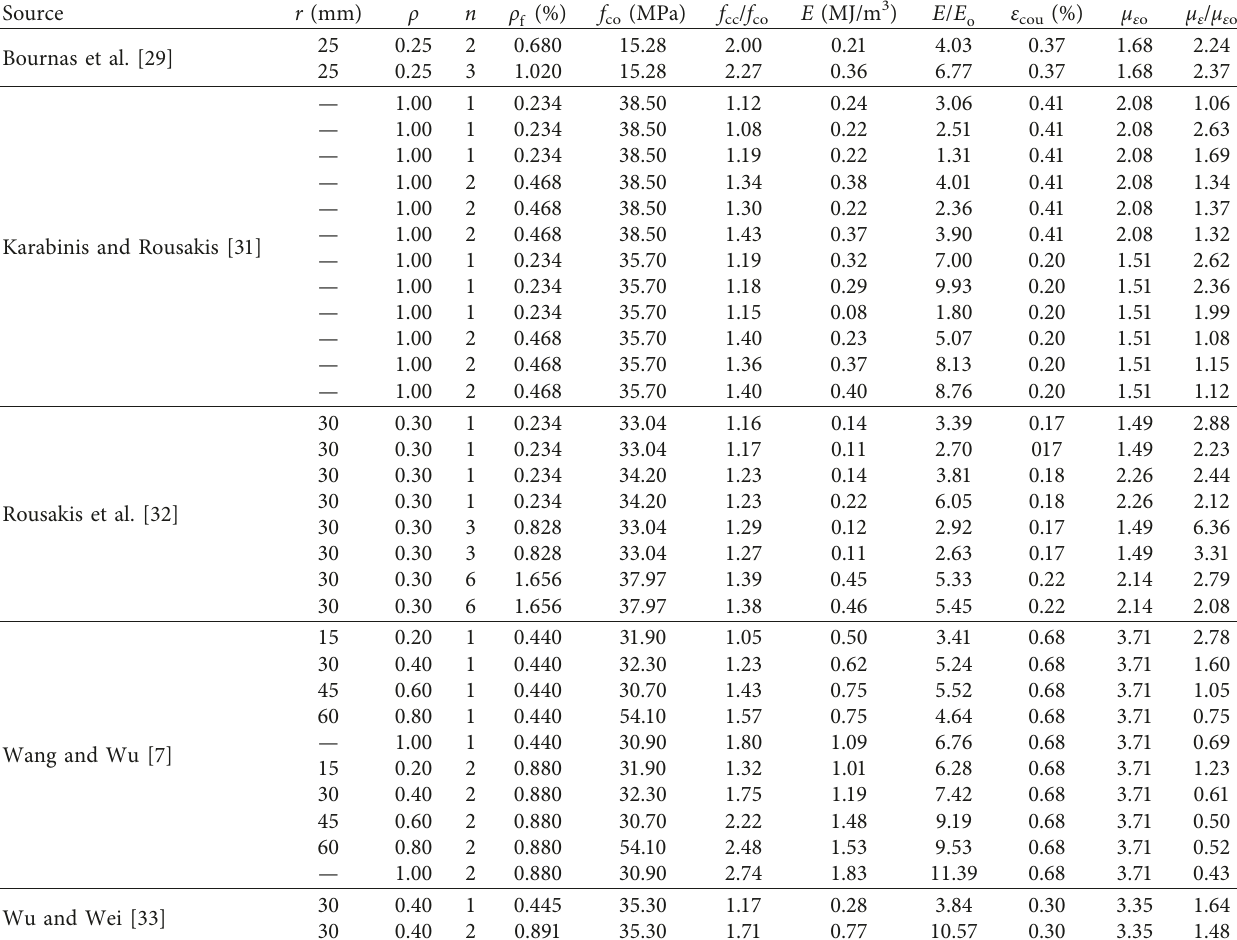
Table 1: Details of FRP-confined column specimens and experimental key